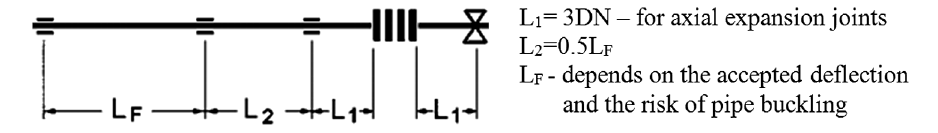
FIG. 4. Schematic diagram of proper supports for the compensation bellows